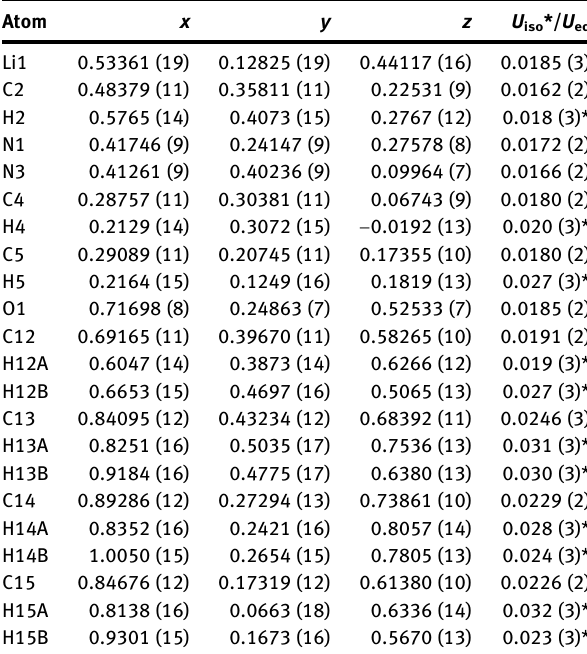
Table  : Fractional atomic coordinates and isotropic or equivalent isotropic displacement parameters (Å 